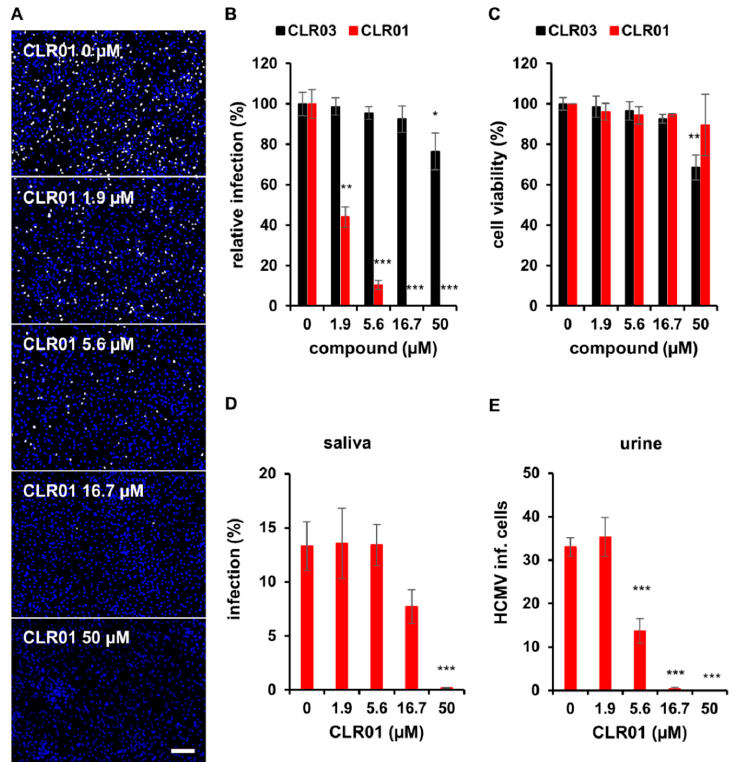
Figure 1. CLR01 inhibits HCMV infection. ( A , B ) Cell-free virus particles of HCMV (strain TB40/E, corresponding to an infection of about 50%) were incubated with indicated concentrations of CLR01 or CLR03 for 30 min at 37 °C prior to infection of human fibroblasts with these mixtures. Infection was determined by indirect immunofluorescence of HCMV IE antigen 24 hpi. ( A ) Representative images of infected cells: blue, DAPI-positive cells; white, HCMV IE-positive cells. Scale bar is 200 µm. ( B ) Means ± SDs of relative infection are from the combined results of three individual infection experiments, each performed in triplicate. ( C ) Cytotoxicity of indicated concentrations of CLR01 and CLR03 on human fibroblasts was controlled after 24 h incubation using the MTT assay. Means ± SDs from two individual experiments, each performed in triplicate. Controls (0 µM) were set to 100% and samples normalized accordingly. ( D , E ) HCMV-positive urine and saliva (undiluted) were incubated with indicated concentrations of CLR01 for 30 min at 37 °C prior to infection of human fibroblasts with these mixtures for 1 h at 37 °C. Cells were stained for HCMV IE antigen by indirect immunofluorescence at 24 hpi. ( D ) Means ± SDs of infection (%) and ( E ) number of HCMV-positive cells per well from triplicate infections. *, p < 0.01; **, p < 0.001; ***, p < 0.0001.